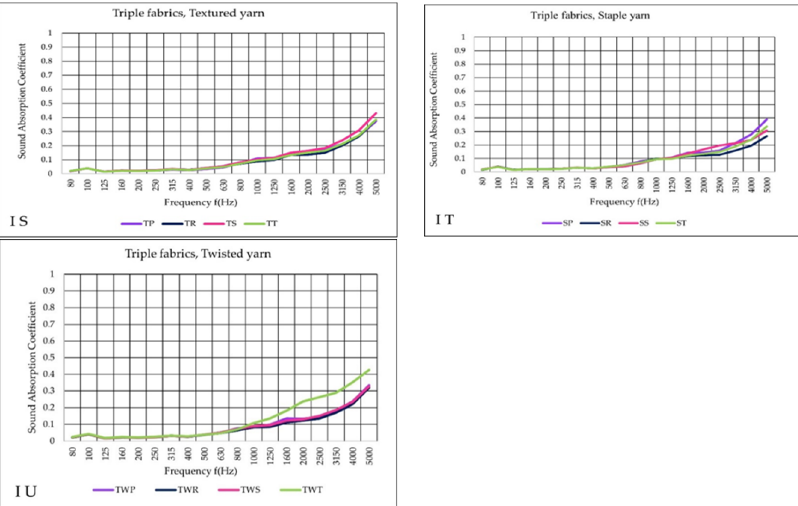
Figure 11. Sound absorption coefficient ( α ) versus frequency f (Hz) for result obtained in I variant ( S – U ) triple woven fabrics.